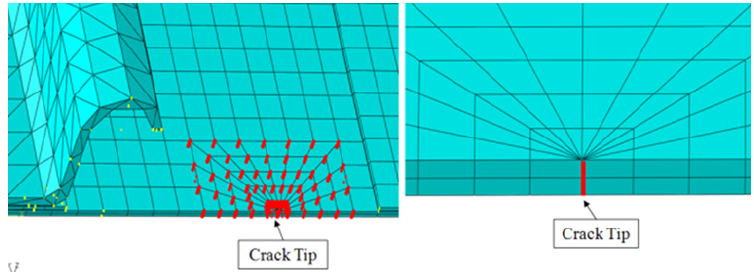
N UMERICAL MODELING